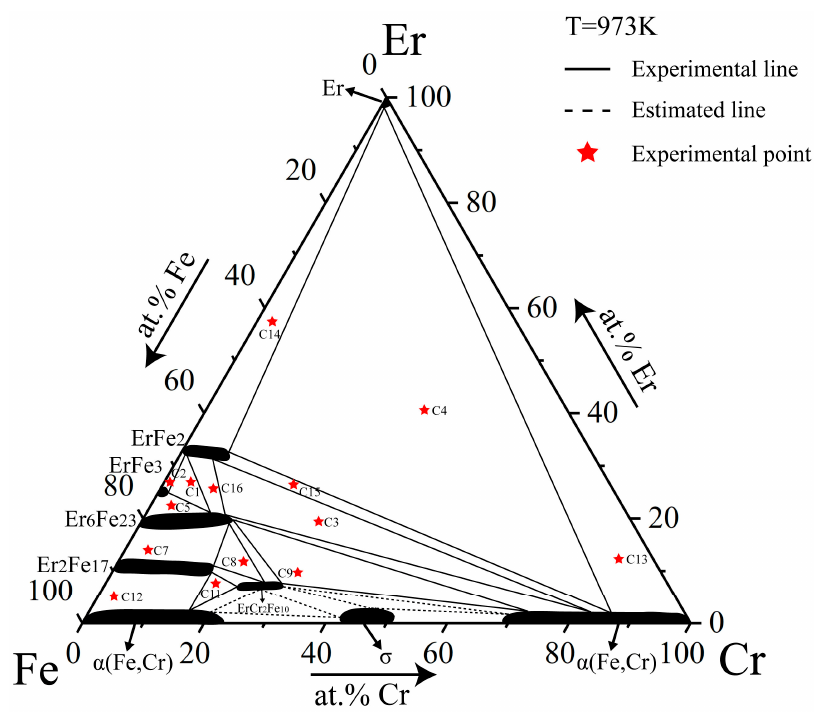
Figure 7. Isothermal section of the Fe–Cr–Er ternary system at 973 K obtained in this work.